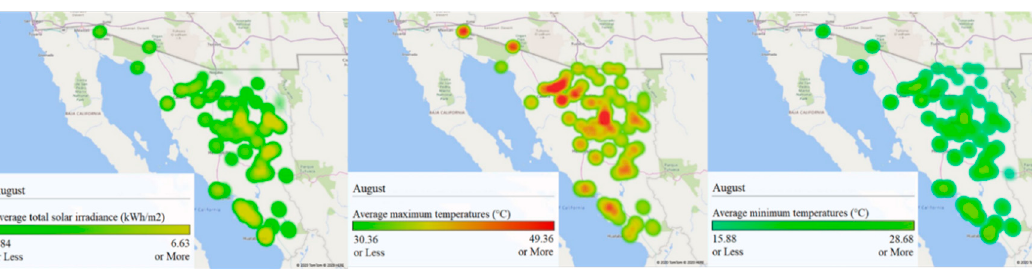
Figure 13. GIS analysis of Sonora for July: ( left ) average total solar irradiance (kWh/m 2 ), ( center ) maximum average temperatures (°C), and ( right ) minimum average temperatures (°C).